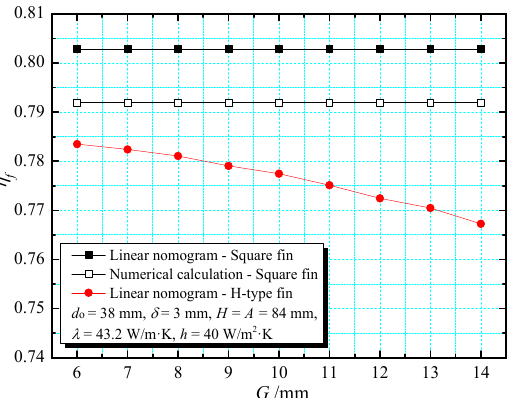
Figure 9. Influence of the slit width of fins on the fin efficiency of H-type and square fins.